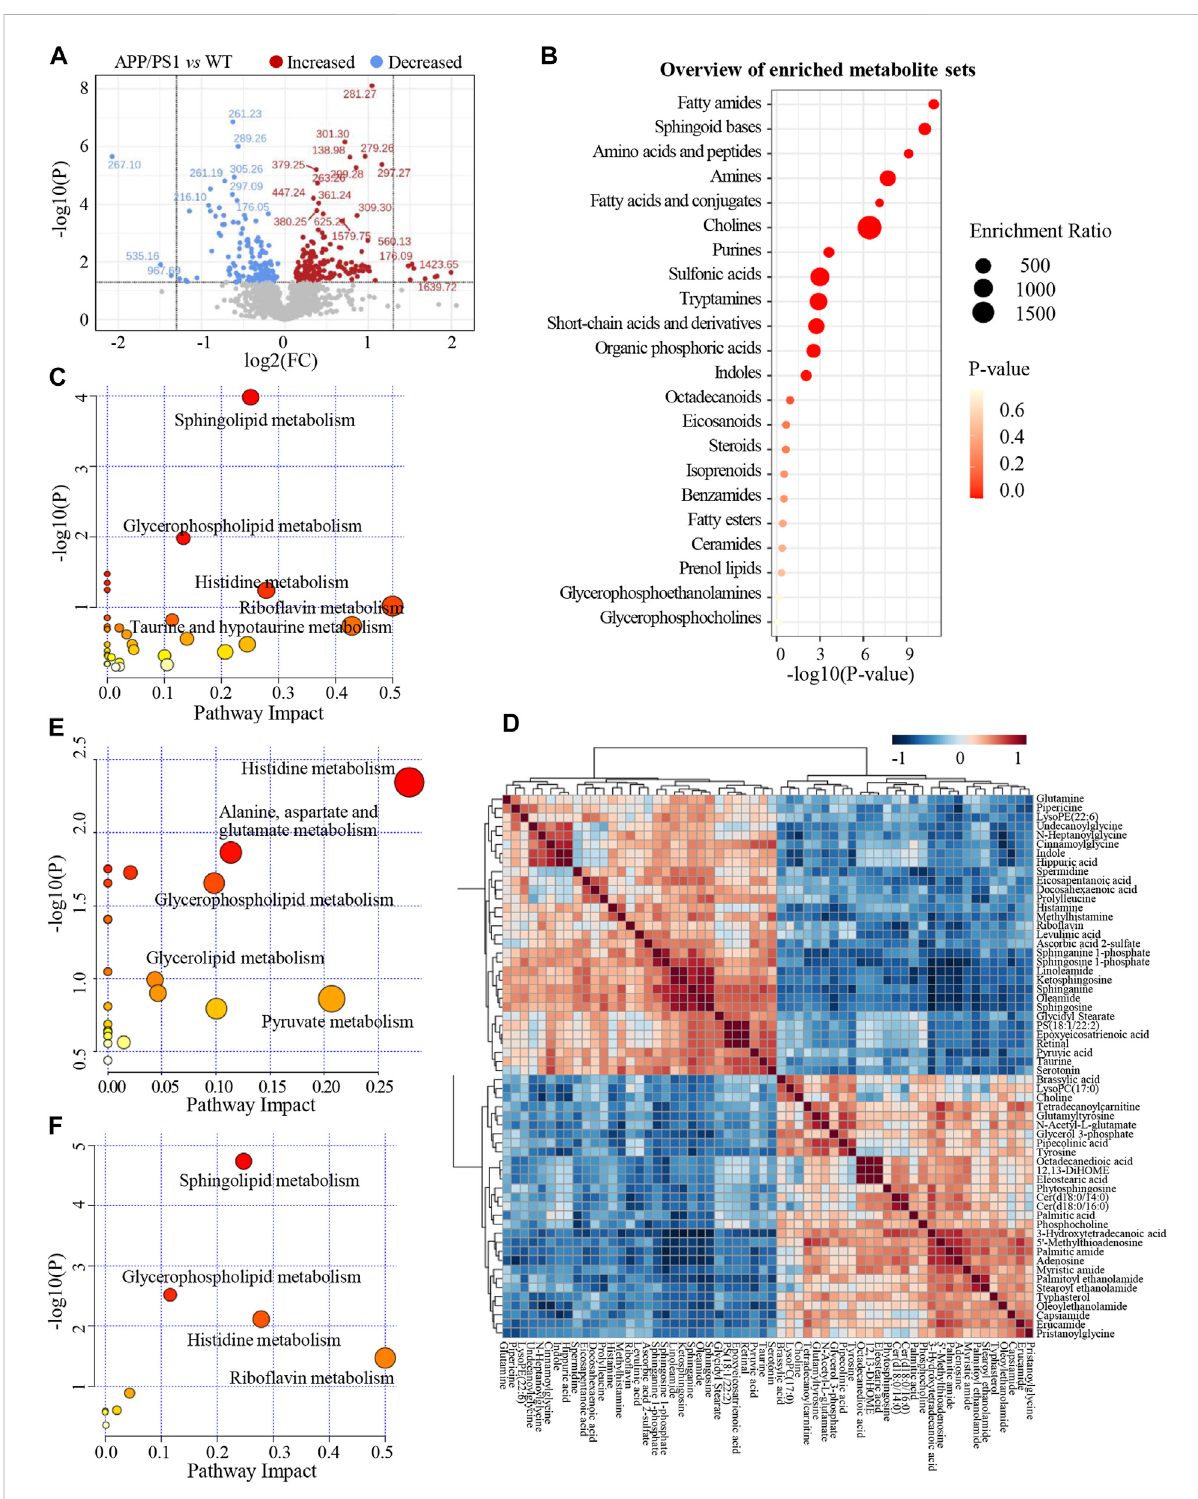
FIGURE 4 (A) The volcano plot of ion features for the comparison between APP/PS1 group vs. WT group. (B) Overview of enriched differential metabolite sets. (C) Metabolic pathways enrichment analysis on the basis of differential metabolites between APP/PS1 vs. WT group. (D) Heatmap of Pearson correlation matrix between the 60 differential metabolites. (E) Metabolic pathways enrichment analysis on the basis of differential metabolites between APP/PS1+GBLE vs. APP/PS1 group. (F) Metabolic pathways enrichment analysis on the basis of differential metabolites between APP/ PS1+Donepezil vs. APP/PS1